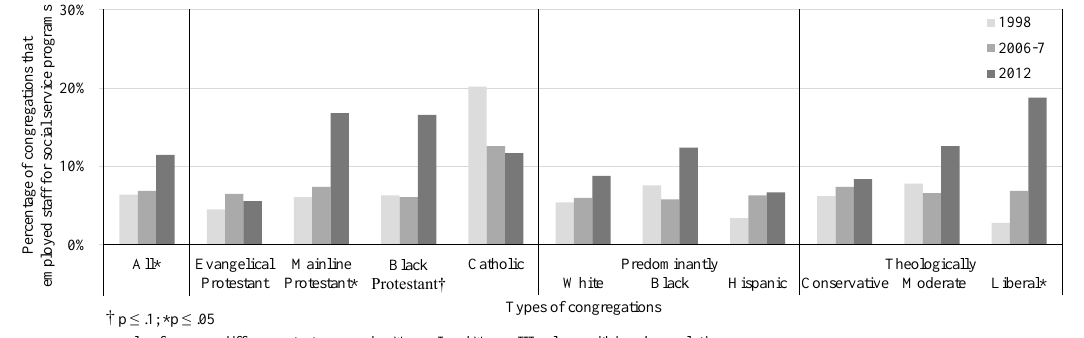
Figure 3. The percentage of congregations by subpopulation that employed staff for social service programs by